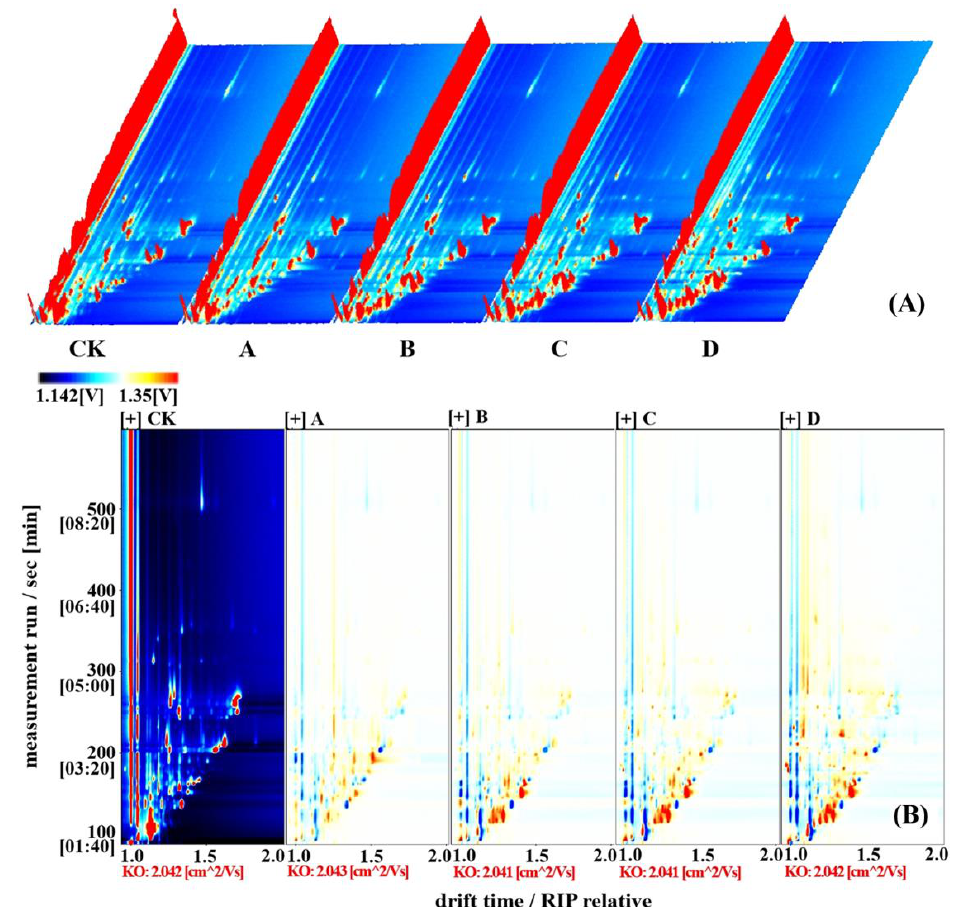
Figure 1. Topographic plot of pomegranate seeds at different processing temperatures. ( A ) 3D topographic plots of VOCs in pomegranate seeds at different processing temperatures; ( B ) 2D topographic plots of VOCs in pomegranate seeds at different processing temperatures (note: CK, A, B, C, and D represent raw pomegranate seeds, and pomegranate seeds processed at 140, 160, 180, and 200 °C, respectively. The same is the case below.).